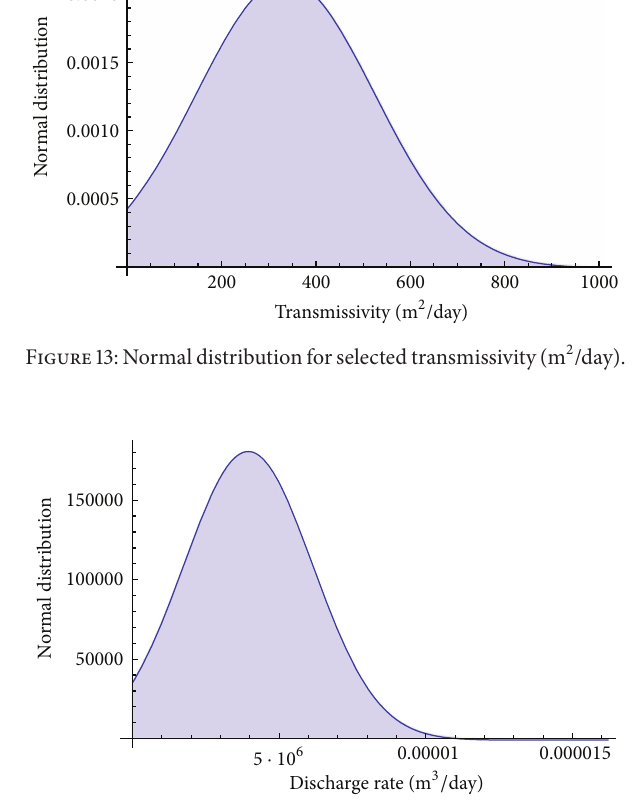
Figure 14: Normal distribution for selected discharge rate (m 3